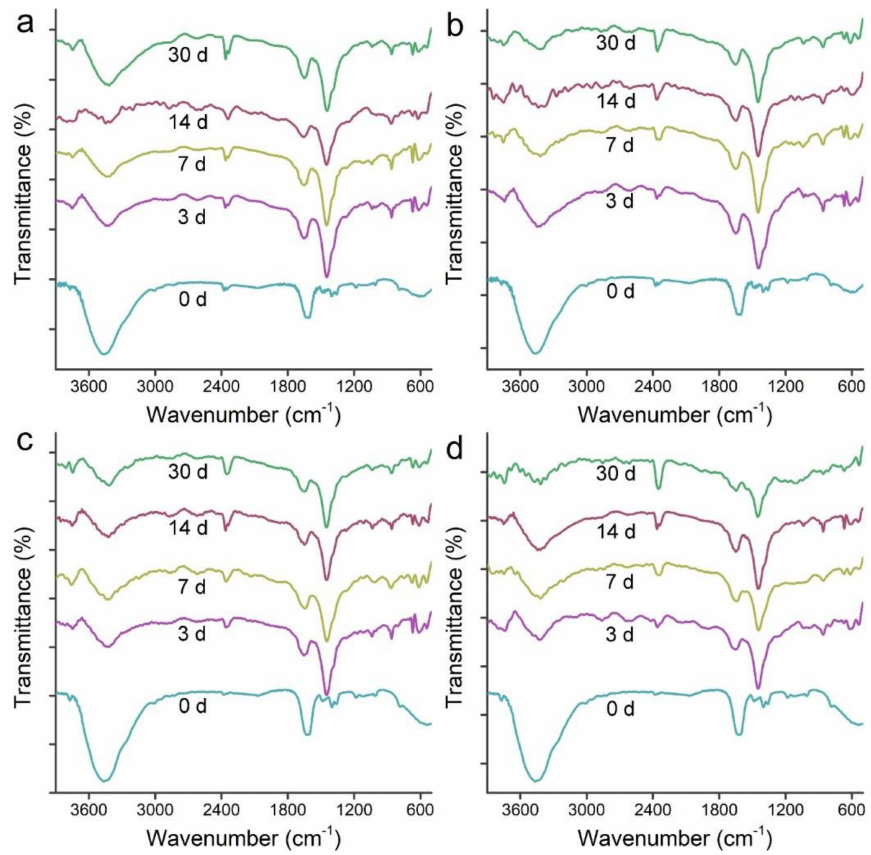
Figure 5. IR spectra of MWCNTs after the incubation with P. chrysosporium . ( a ) Wrapped p-MWCNTs; ( b ) precipitated p-MWCNTs; ( c ) wrapped o-MWCNTs; ( d ) precipitated